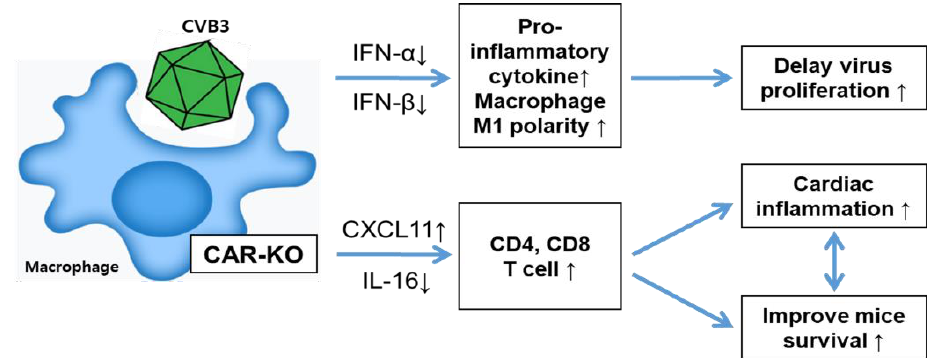
Figure 7. A proposed model of the mechanism of macrophage-specific CAR deletion in CVB3 infec- tion. CVB3 binds with its receptor and initiates an early innate immune response. Viral infection induces macrophage M1 polarity and CXCL-11 expression, which upregulates the induction of CD4- and CD8-positive T lymphocytes into cardiac focal inflammatory lesions. This results in posi- tive feedback that increases M1 macrophage activation and delays viral replication. T-cell activation might have the beneficial effect of maintaining the subacute phase of mice